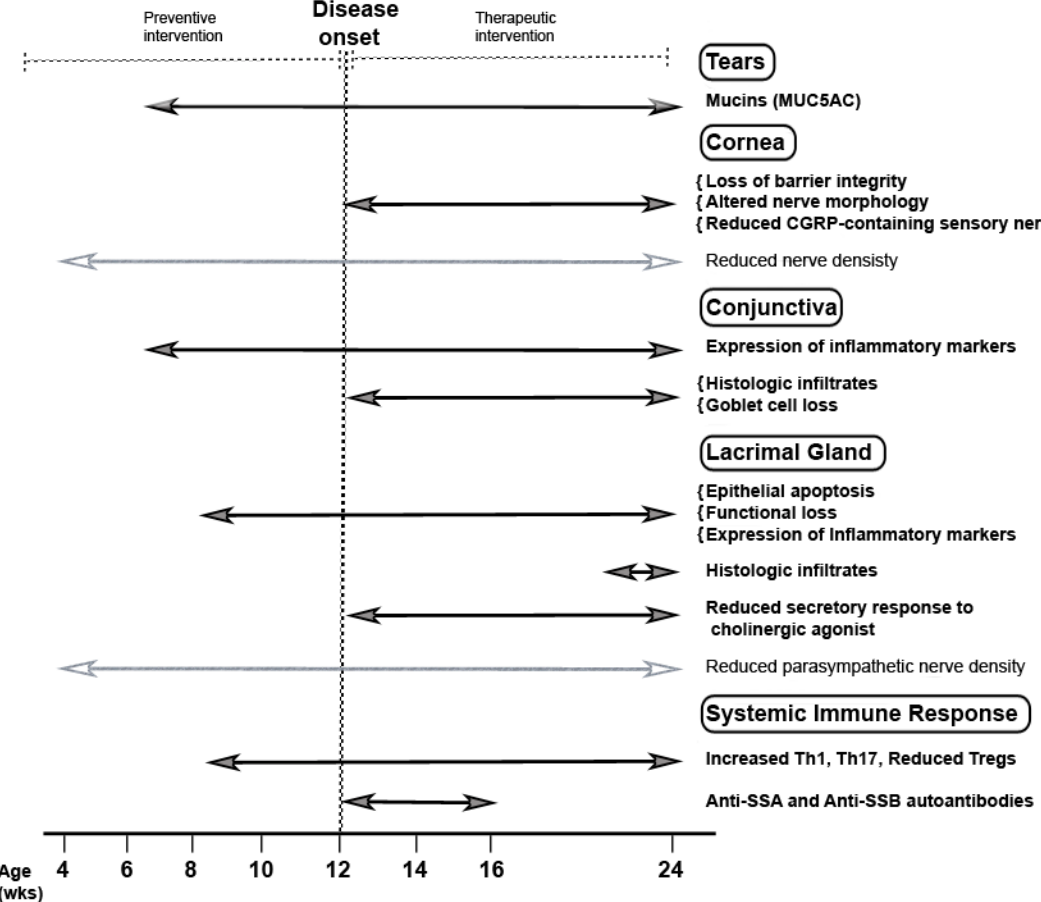
Figure 5. Pathologic changes that elucidate chronological and progressive development of SS related ocular surface disease in TSP-1 − / − mice. Earliest changes related to SS development in Table 1. Mice are subclinical and noted at the age of 6 weeks in the form of expression of inflammatory e ff ectors in the conjunctiva and consequential loss of tear MUC5AC content. At the age of 8 weeks, changes in the LG epithelial cells, their functional loss, and peripheral immune response are detected. These changes are followed by the disruption of corneal barrier integrity, altered corneal nerve morphology, conjunctival infiltrates, and loss of conjunctival goblet cells 12 weeks onwards and are also accompanied by the development of SS related autoantibodies. All these changes precede the appearance of histologically detectable inflammatory infiltrates in the LG. Reduced nerve densities in the cornea and LG are detected at all tested ages and appear to be independent of inflammation (identified by light gray lines with empty arrowheads). However, inflammation disrupts secretory responses of LG cells to neural stimuli and impairs lacrimal functional unit resulting in ocular surface disease. Overall, progressive changes in this preclinical model show the clear onset of ocular manifestations at 12 weeks marking two clear phases before and after the onset that allows for testing of preventive as well as therapeutic interventions, respectively.